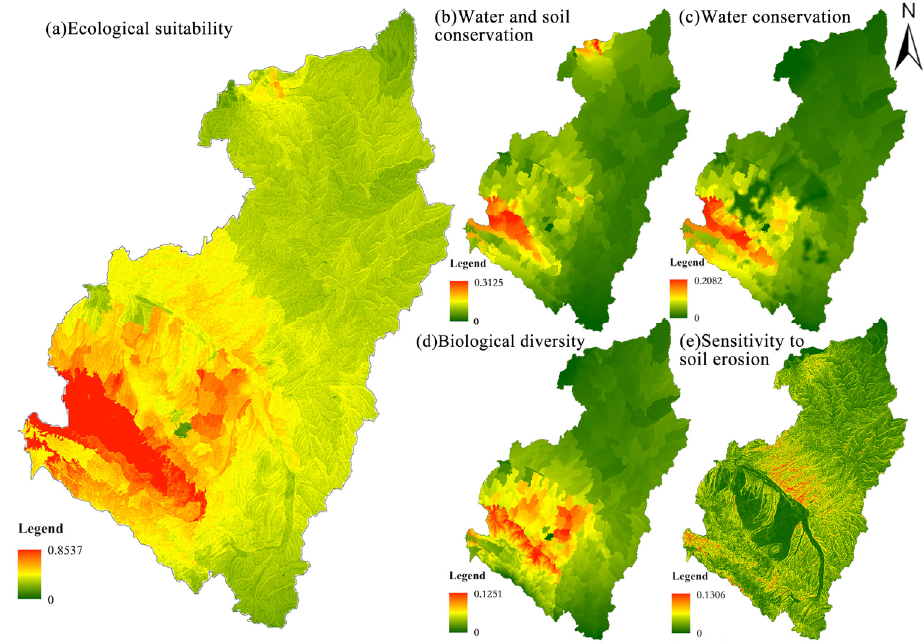
Figure 6. The spatial distribution of the ecological protection suitability.